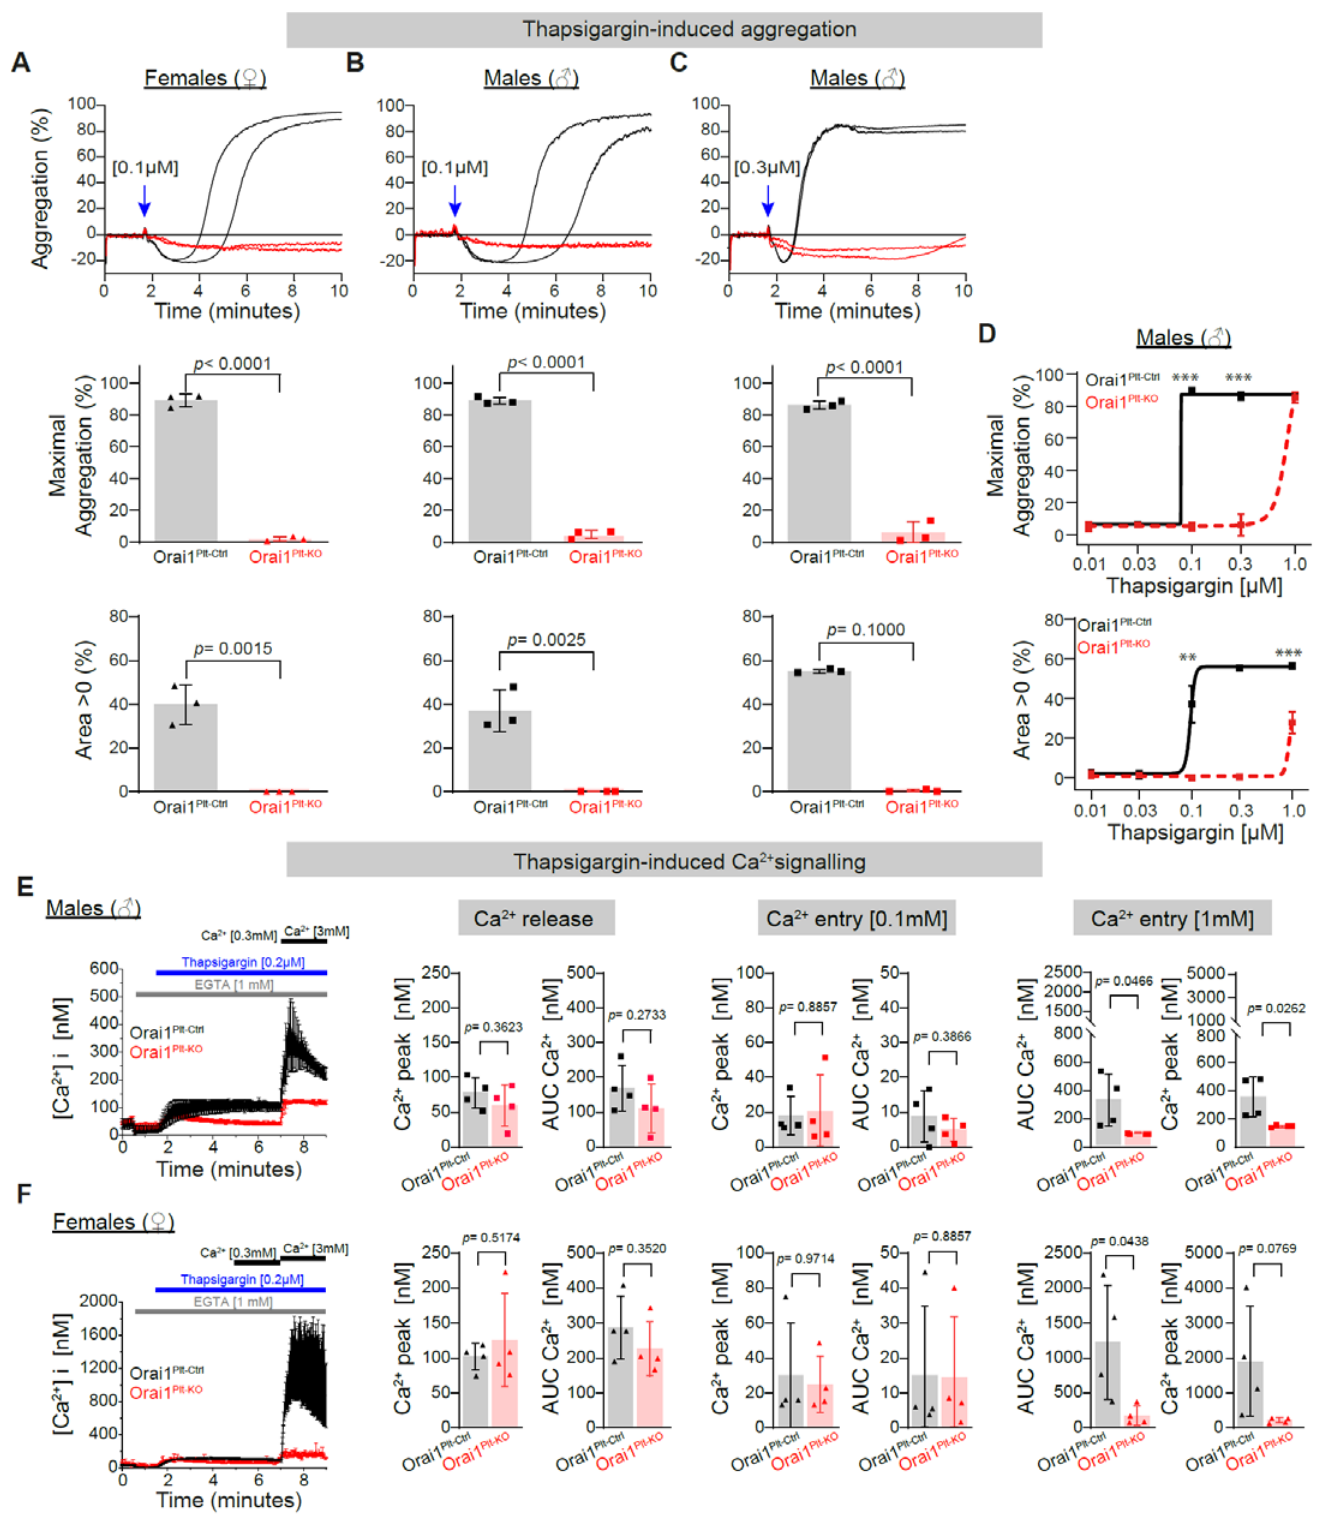
Figure 5. Abolished thapsigargin-induced platelet aggregation and Ca 2+ entry in Orai1 deficient platelets. Thapsigargin-induced platelet aggregation in washed platelets from Orai1 Plt-Ctrl (black) and Orai1 Plt-KO (red) mice was analysed ( A – D ). Representative original aggregation traces (upper panels), analysis of maximal aggregation (middle panels) and area under the aggregation curve (lower panels) after stimulation with 0.1 µM Thapsigargin of platelets from female ( A ) or male ( B ) mice; similarly, analysis in platelets from male mice stimulated with 0.3 µM thapsigargin are depicted ( C ).